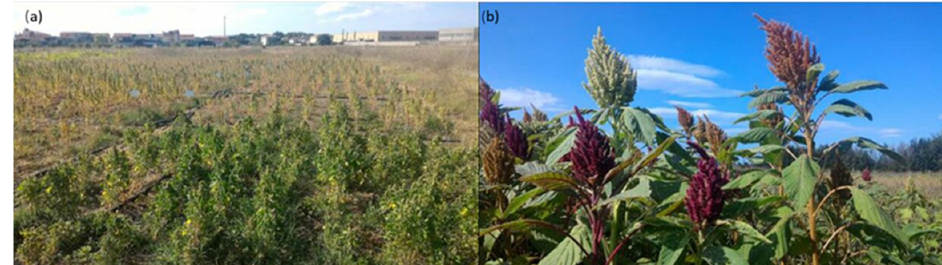
Figure 1. Quinoa ( a ) and amaranth ( b ).